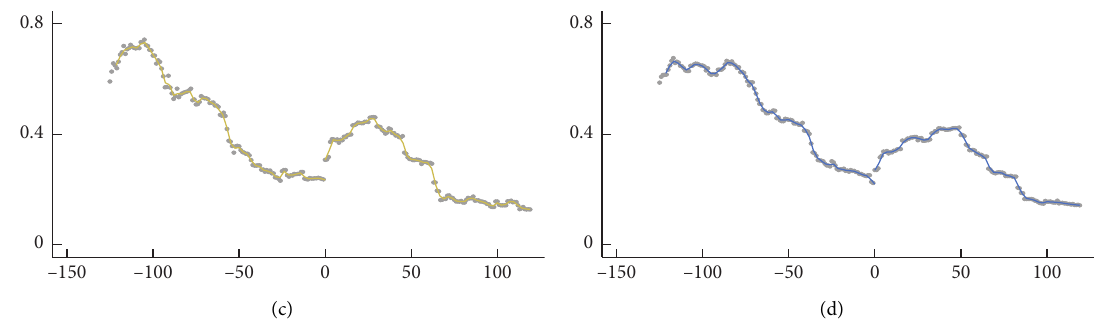
Figure 4: The RDD results of the public industry. (a) hv5, (b) hv15, (c) hv30, and (d)